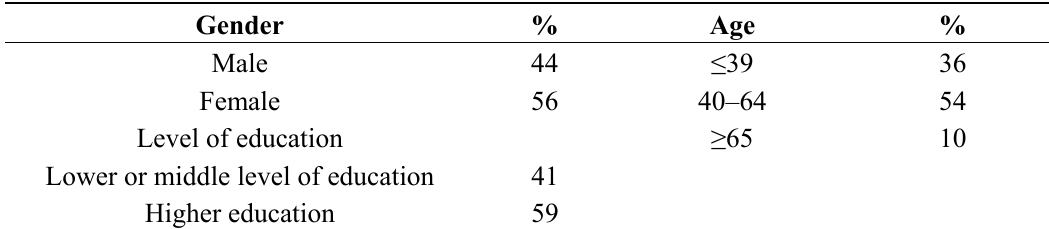
Table 1. Background characteristics of Amsterdam respondents of the Hotspotmonitor (%) (n =